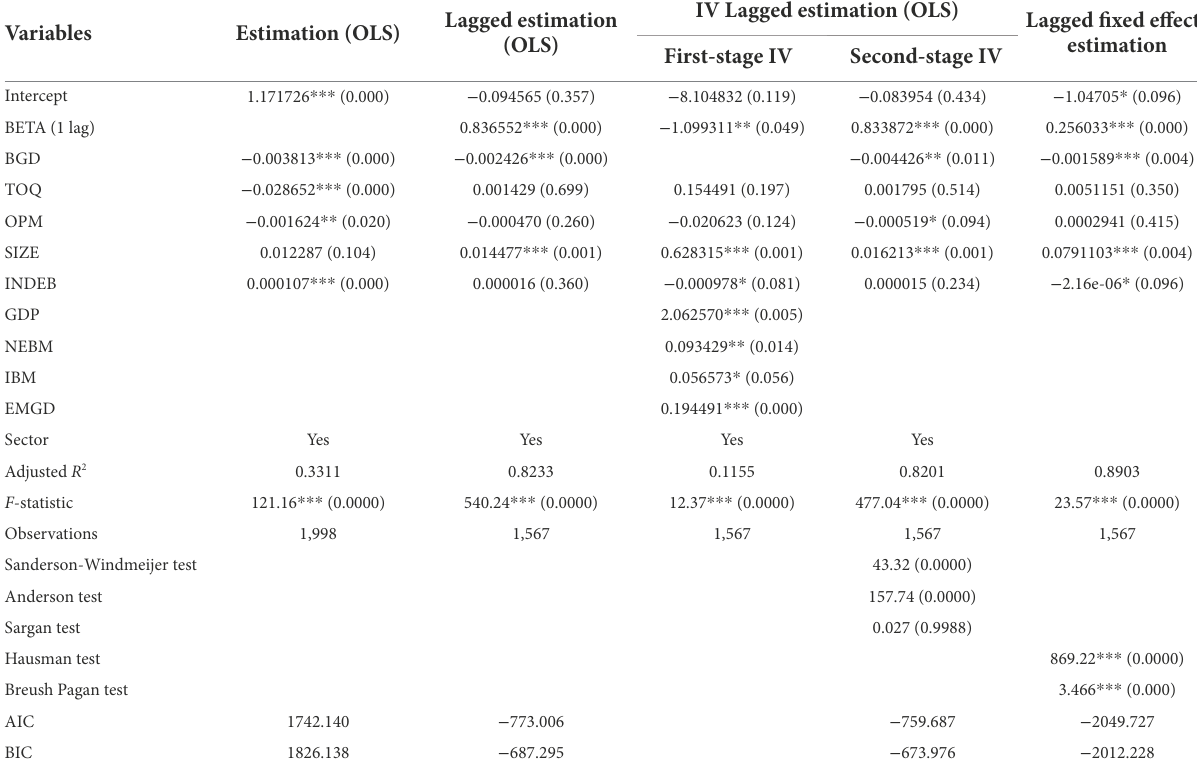
TABLE 8 Regressions in the U.S.